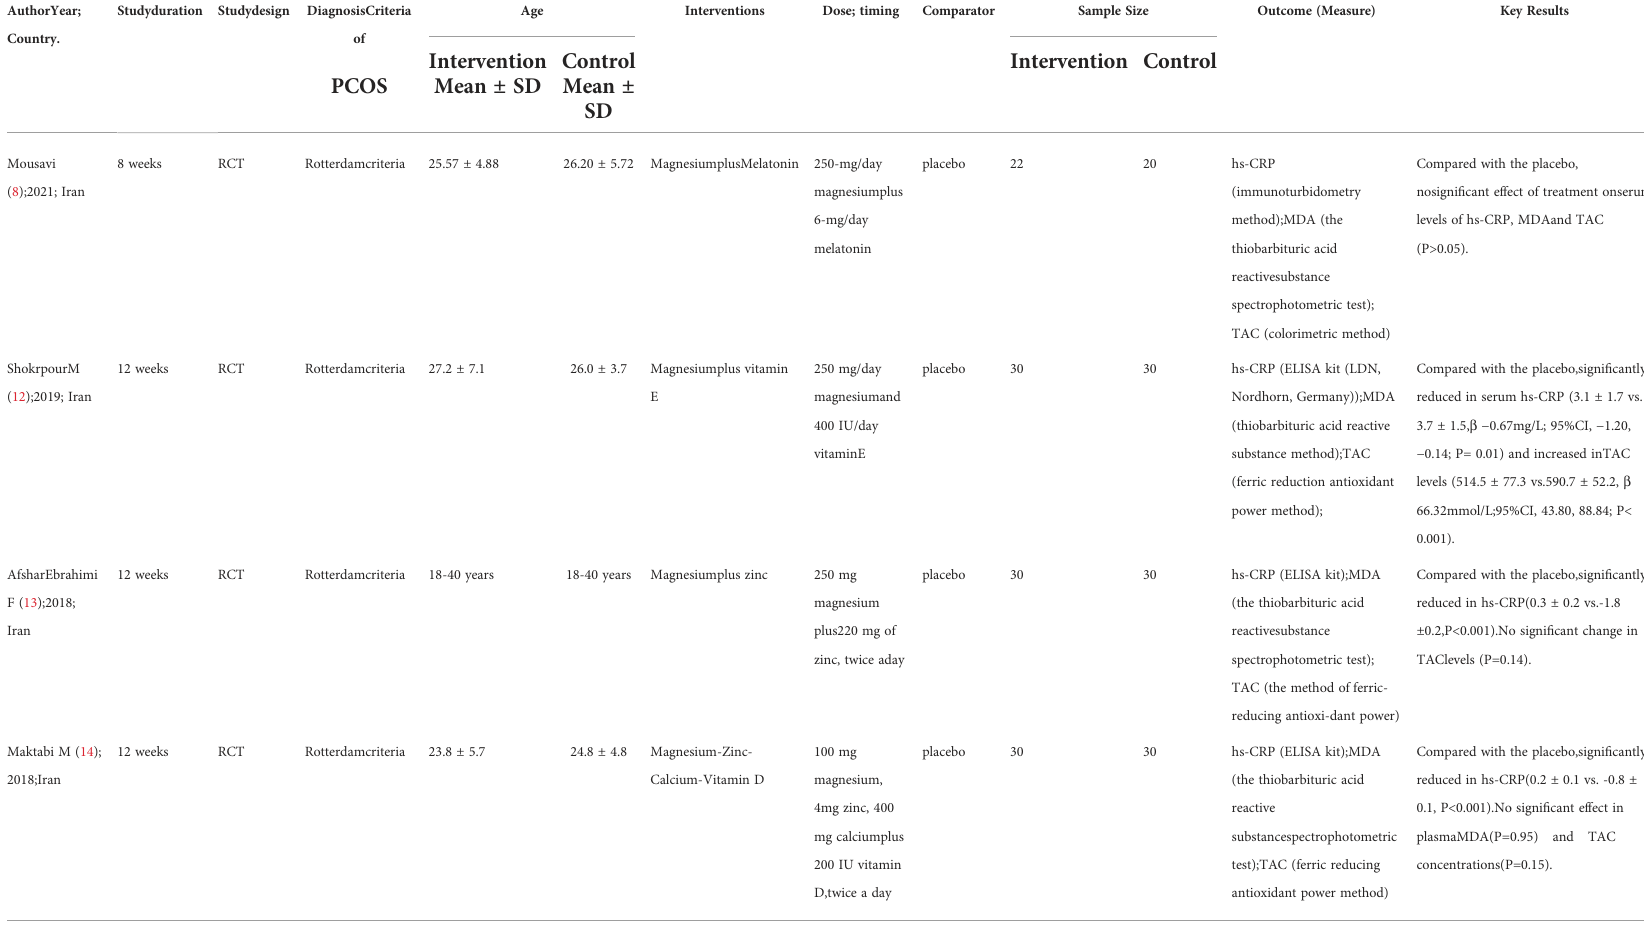
TABLE 2 Summary the characteristics of studies on the impact of combined magnesium supplement on metabolism of PCOS.